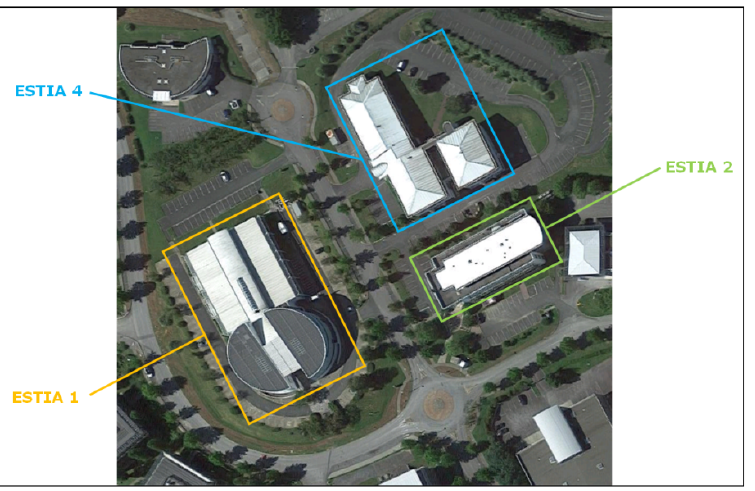
Figure 1. Buildings participating in the CSC of the Izarbel pilot project. of ESTIA Institute of Technology.